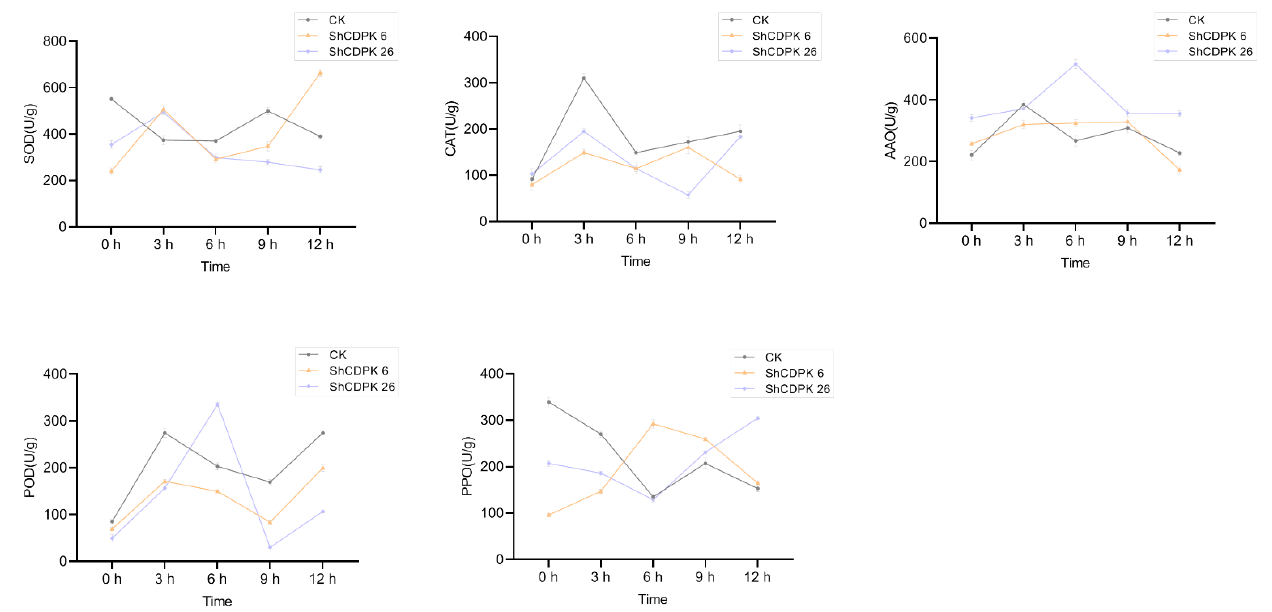
Figure 8. Determination of physiological indexes of ShCDPK6 and ShCDPK26 silenced plants and control plants under drought stress. Activity of SOD, CAT, AAO, POD, PPO. Each value is the mean ± standard deviation of at least three independent measurements.